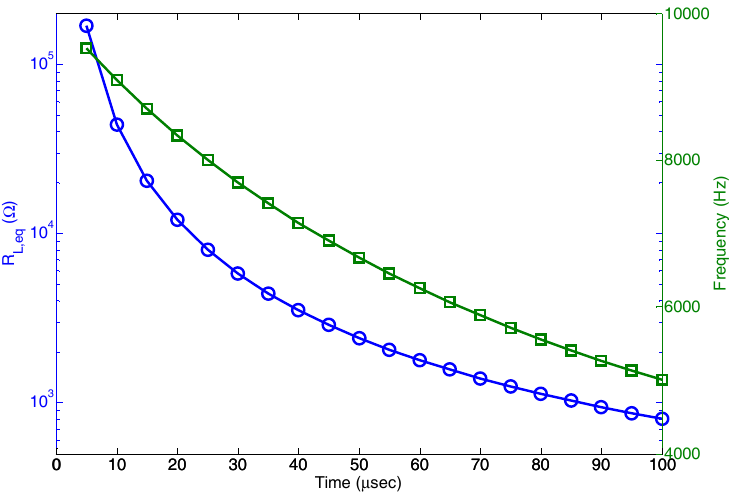
Figure 10. Equivalent resistor value R L , eq (circles) and frequency of oscillation (squares) of the clock signal obtained as a function of the t ON time of the driving waveform between 5 and 50 µ s. The t OFF time has been kept constant at 100 μ s.